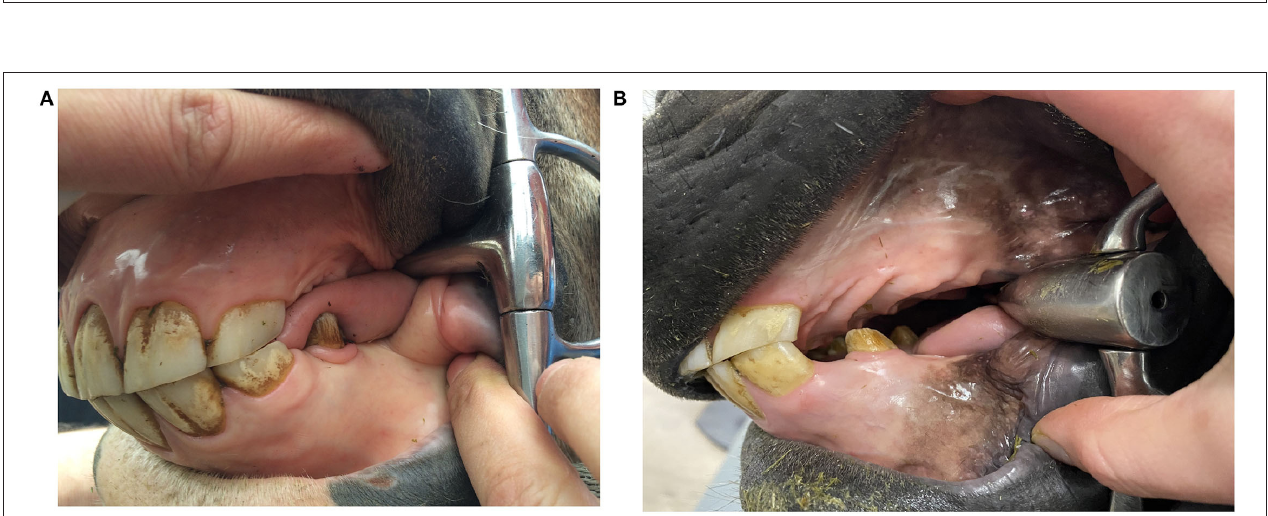
FIGURE 5 | Bit thickness fit: (A) a bit that fits—tongue has enough space, (B) a bit that is too thick—too small space left for tongue, tongue retracted partly behind the bit.